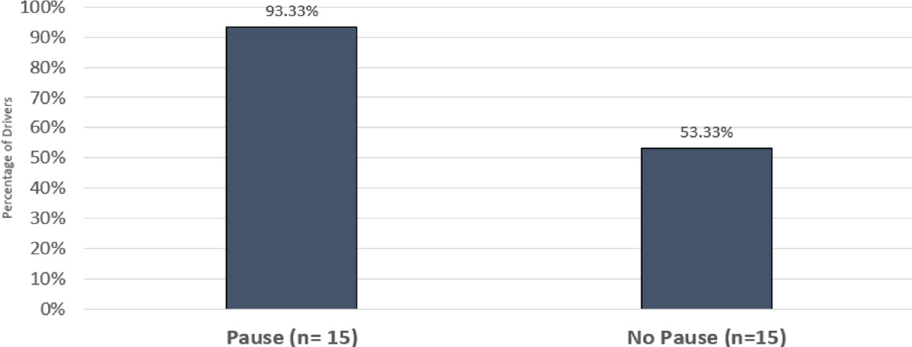
Figure 5. Percentage of drivers, by experimental condition, who detected the lead vehicle’s hazard lights preceding the muffler drop hazard (self-report).